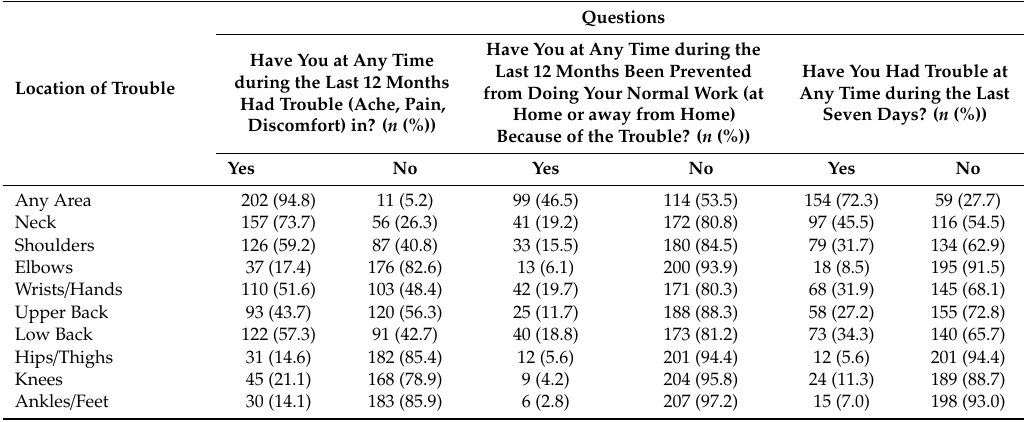
Table 3. Number of complaints by region and number of a ff ected areas ( n = 213).